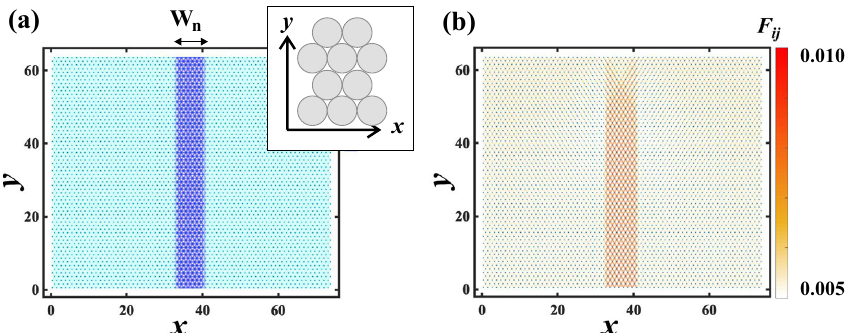
Figure 1. ( a ) k ij distribution. Dark color corresponds to k ij = 3, while bright color corresponds to k ij = 1. W n is a width of G h region. The inset schematic shows the arrangement of the triangular lattice. ( b ) Magnitude of the force is represented by the color, as indicated by the color bar. The force is larger in G h